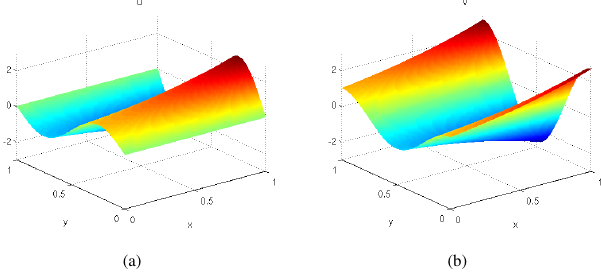
Figure 2. Plots of exact solutions to the x – y MMS test case: (a) u , (b) v .